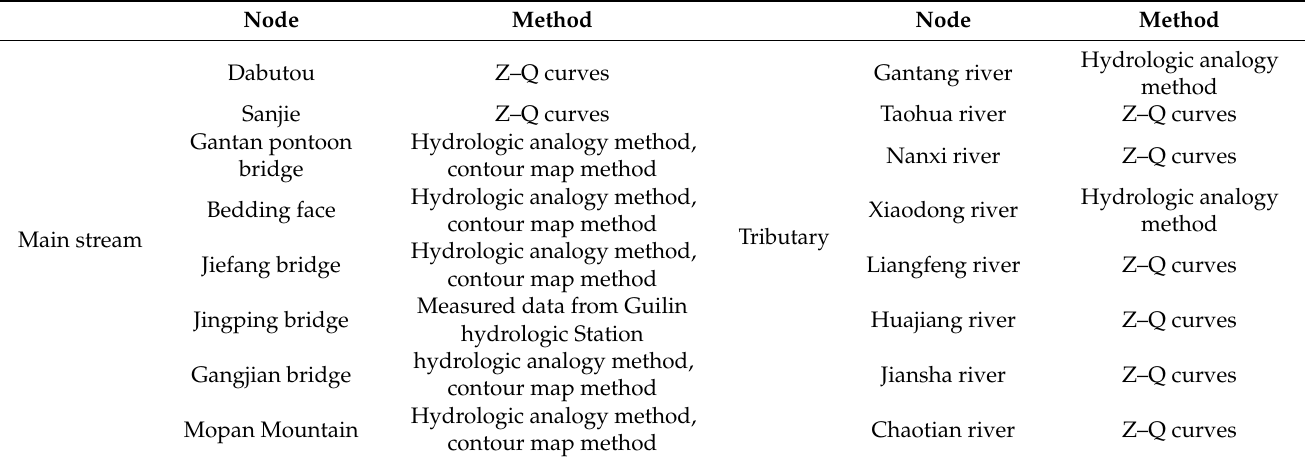
Table 2. Flow interpolation method for main stream and tributary nodes.